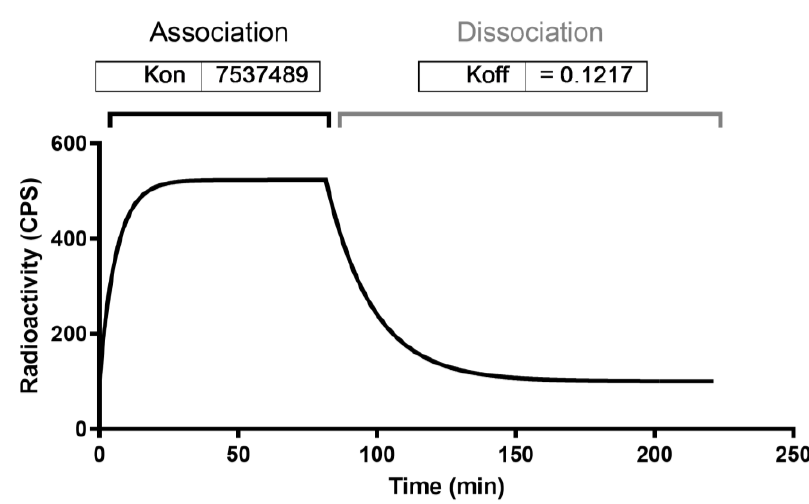
Figure 2. Kinetic binding assay of radiolabelled anti-TNF α mAb on J744A.1 cells.